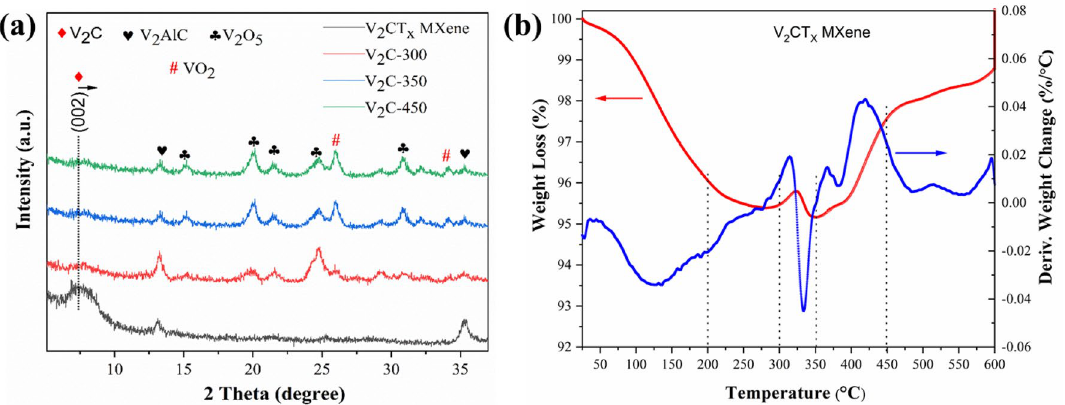
Figure 5. ( a ) XRD patterns of pristine V 2 CT x MXene and MXene-derived V 2 C-300–450 samples calcined at different temperatures (from 300–450 °C); ( b ) TG–DTA analysis of the V 2 CT x MXene